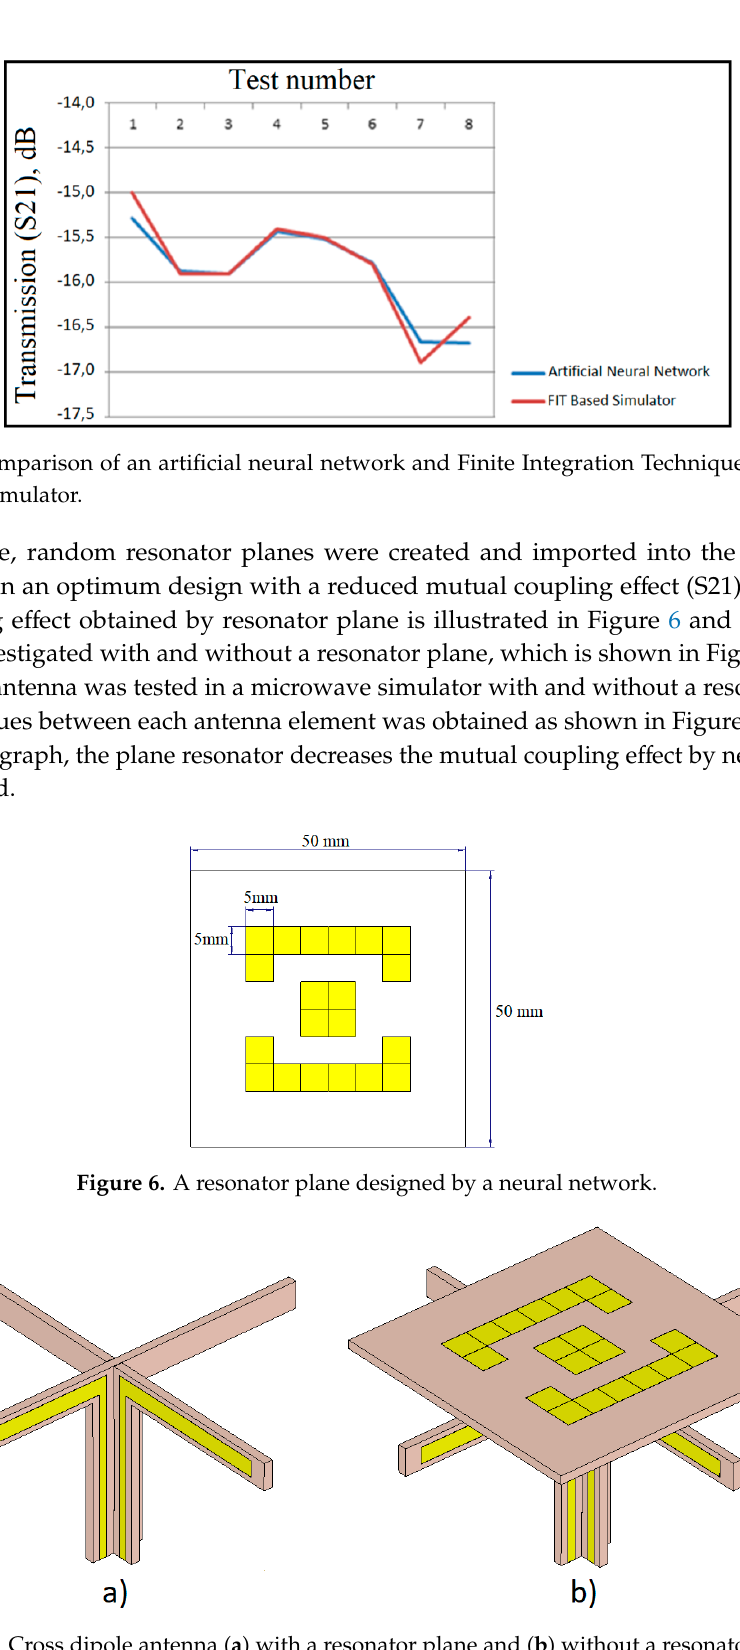
Figure 8. The mutual coupling effect between cross dipole antennas. 5. Experimental Investigation and Results The designed cross dipole antenna and plane resonator was fabricated by a LPKF-E33 circuit printer, as shown in Figure 9. The figure shows only a cross dipole antenna with a connected SMA port and plane resonator integrated cross dipole antenna with an SMA port, respectively. Experimental measurements were carried out by an Agilent PNA-L vector network analyzer as given in Figure 10a, and measured transmission values are plotted in Figure 10b. According to the measured transmission values, the resonator plane reduced transmission values between each antenna of cross dipole antenna, which led to a mutual coupling effect being decreased when using this resonator layer. At the frequency of 2.4 GHz, a cross dipole antenna has mutual coupling (S21) of − 19.7 dB but it is − 25.3 dB with the use of a plane resonator layer. As a result of this study, a trained artificial neural network provides an accurate solution for mutual coupling effect between each element of cross dipole antenna with an error rate of less than 2%, as given in Table 2.